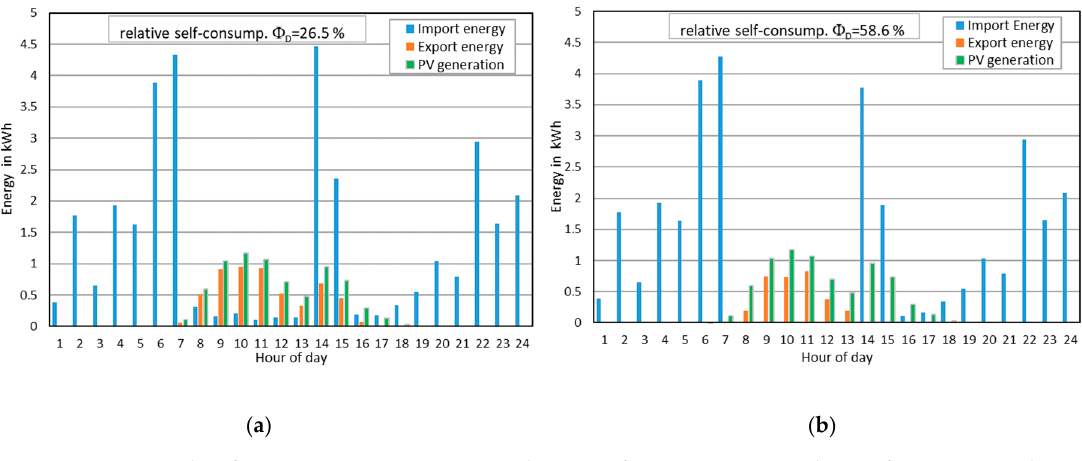
Figure 3. Graphs of generation, consumption and export of energy on 18 March 2019 for a meter with ( a ) arithmetic ( b ) vector mode.